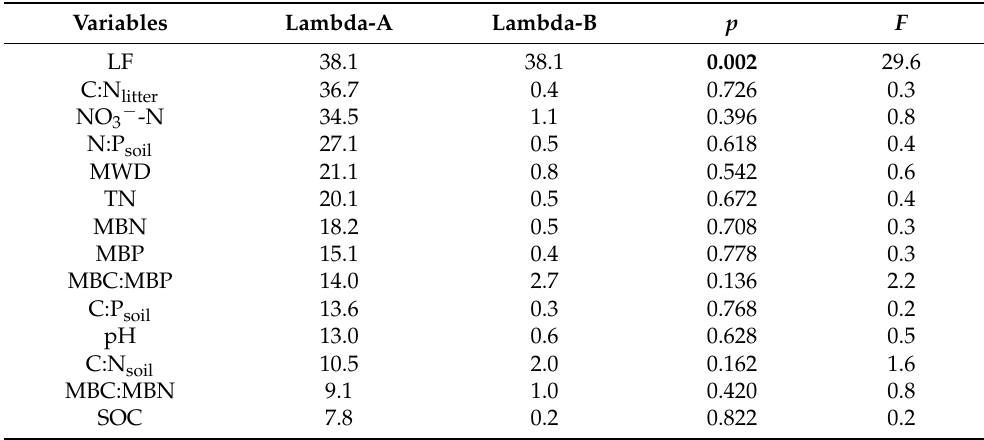
Table 5. Simple and conditional effects of environmental factors on soil extracellular enzymatic stoichiometry (EES) in the redundancy analysis